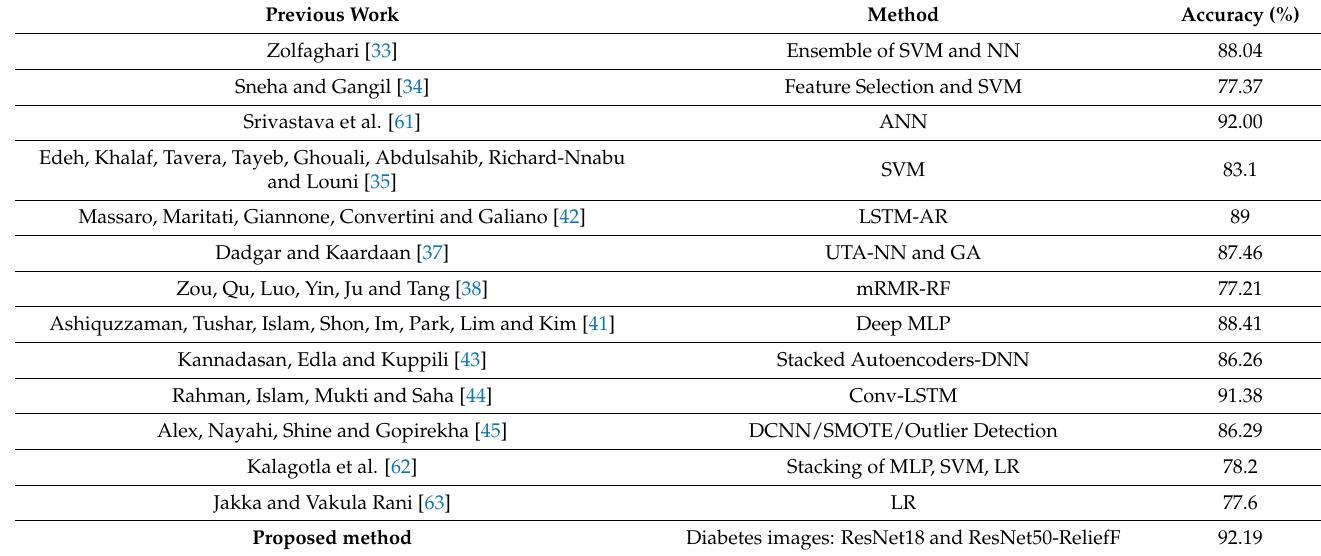
Table 5. Comparative analysis with previous